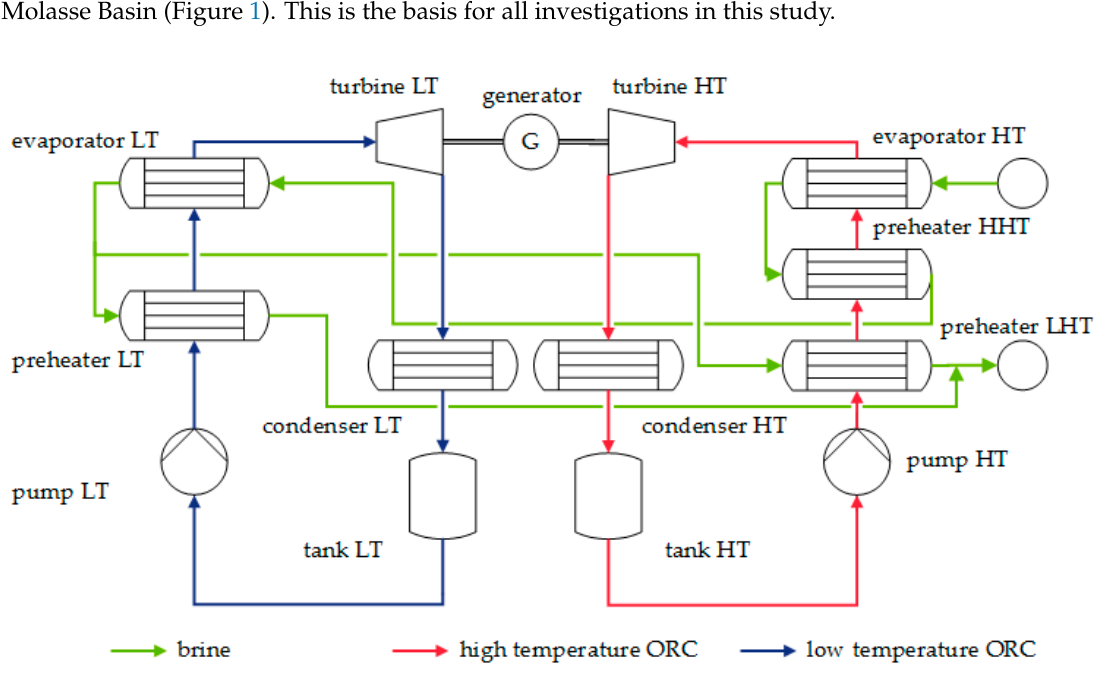
Figure 1. Scheme of the double-stage organic Rankine cycle (ORC) power plant.